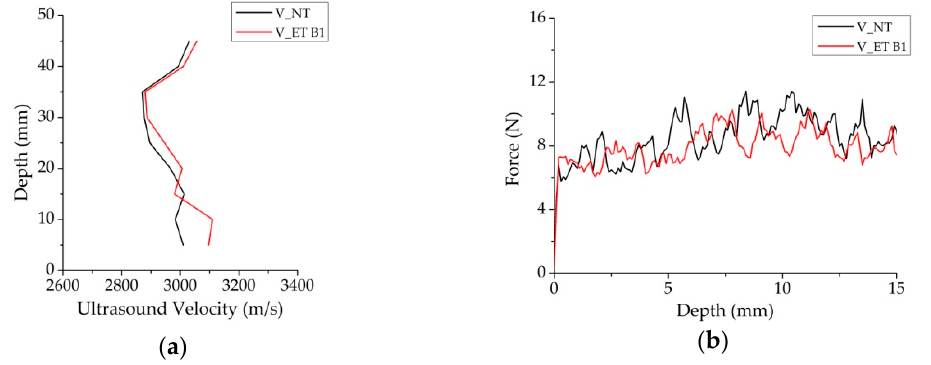
Figure 10. ( a ) Ultrasonic and ( b ) drilling profiles of Vicenza stone treated with ET B1reported as a comparison before and after treatment.